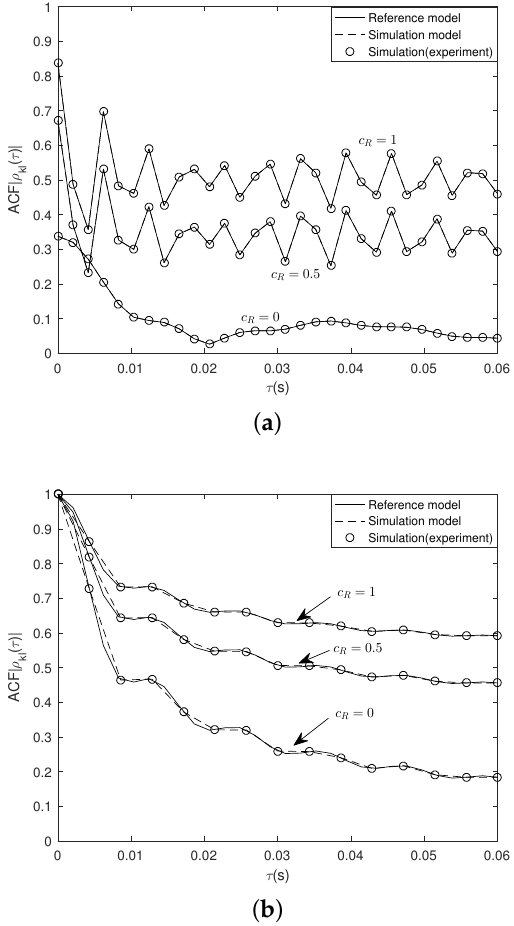
Figure 7. ACF of SET and without ceiling for different Rice factors c R . ( a ) ACF of SET. ( b ) ACF of SET without